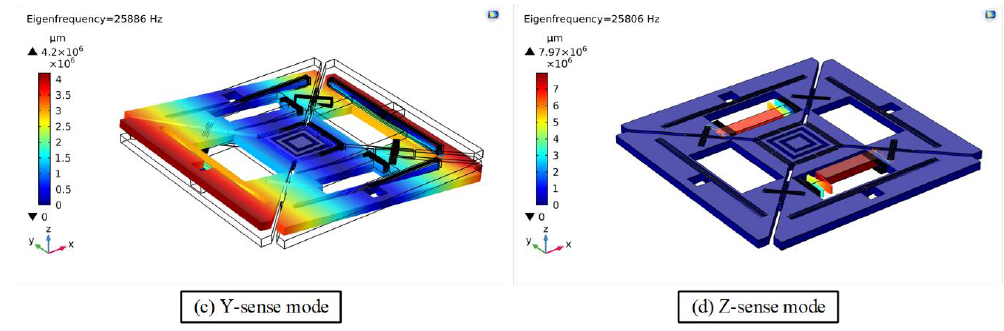
Figure 2. Resonant frequency mode shapes of the proposed single-drive, 3-axis MEMS gyroscope.